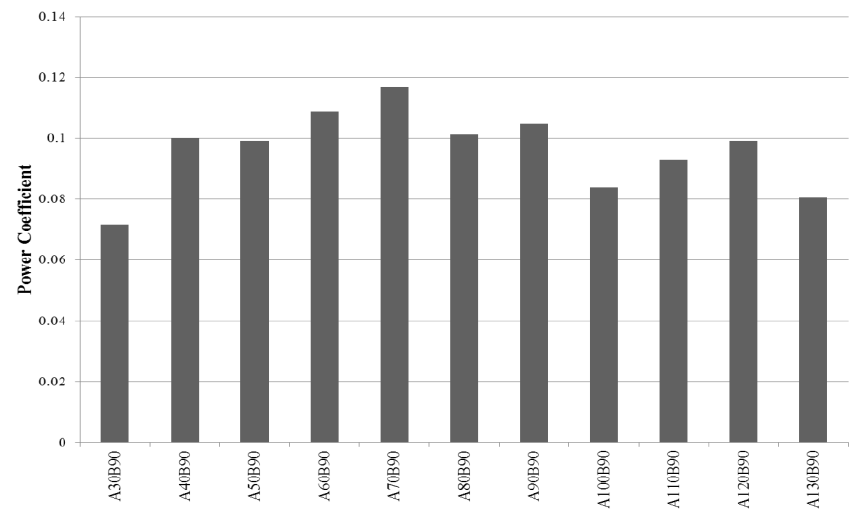
Figure 13. Effect of guide vane “A” angle on power coefficient Table 3. The results and other specifications of the various cases